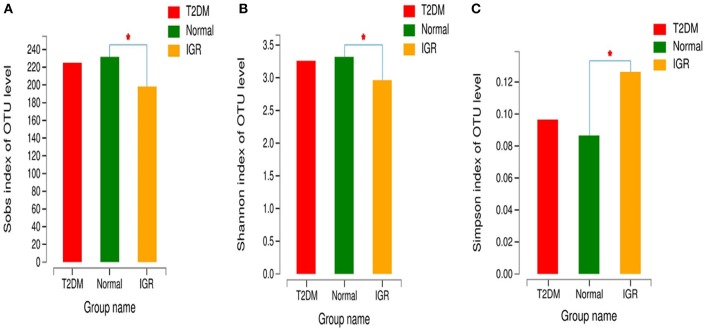
Comparison of α-diversity indexes in T2DM, IGR, and NC groups. *Compare two group, P < 0.05 (A) α diversity-Sobs index bar chart (B) α diversity-Shannon index bar chart (C) α diversity-Simpson index bar chart.